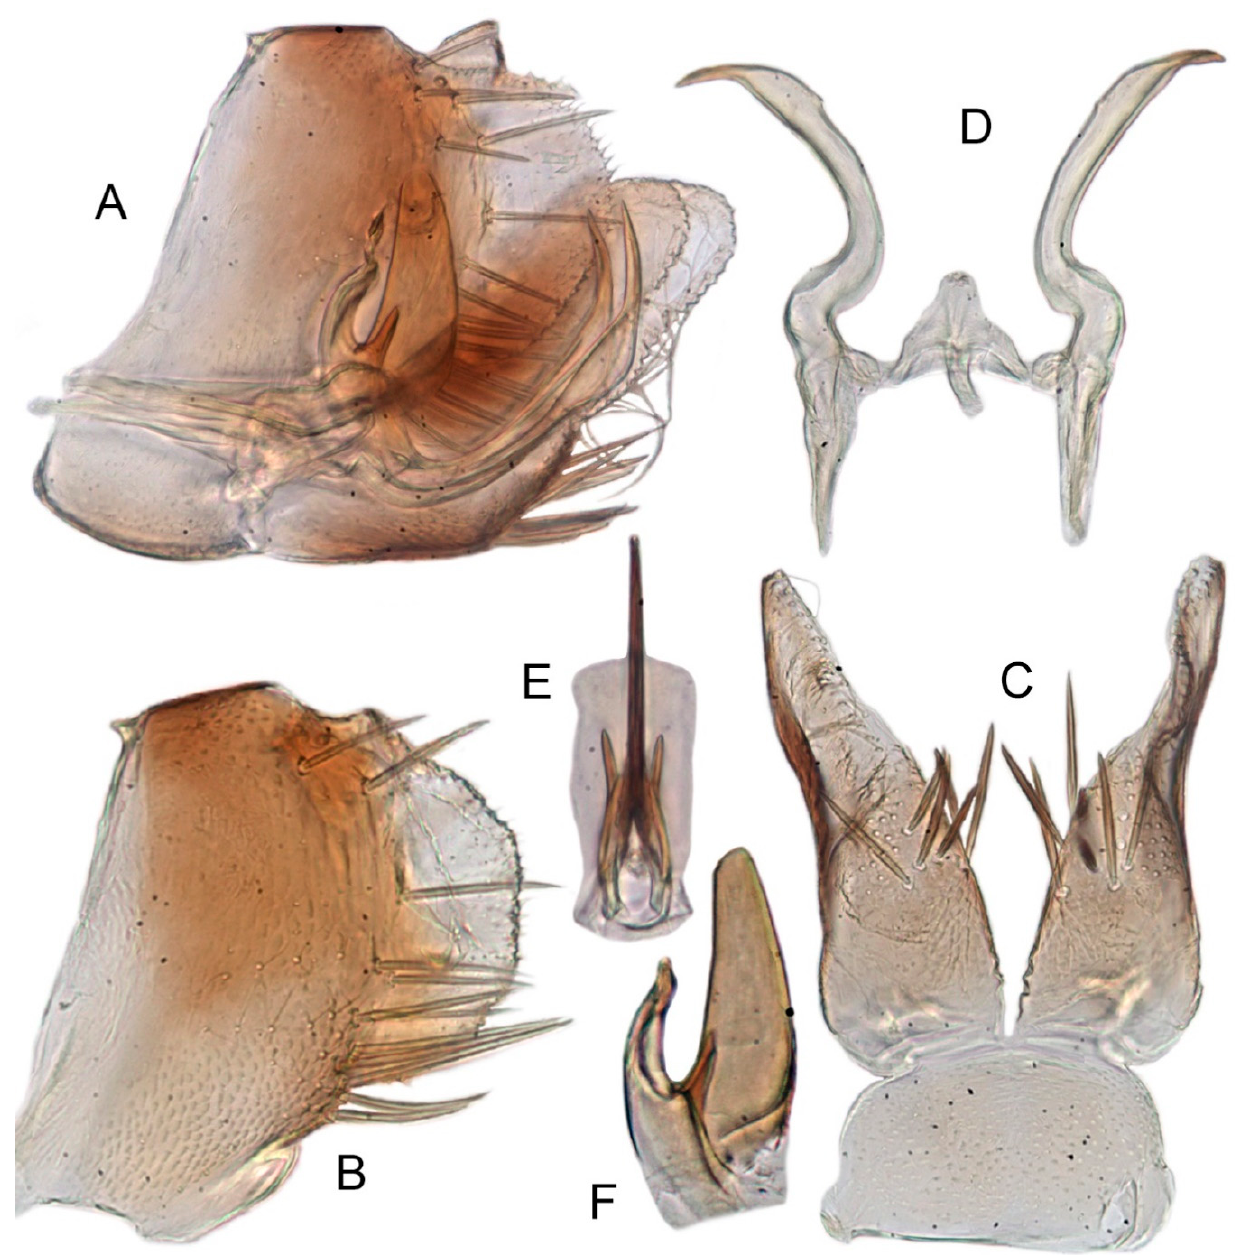
Figure 17. Xestocephalus abyssinicus Heller and Linnavuori, 1968, n. rec. ( A ) Male genital capsule, lateral view; ( B ) pygofer lobe, lateral view; ( C ) subgenital plates and valve, ventral view; ( D ) style and connective, ventral view; ( E ) aedeagus, posterior view; ( F ) aedeagus, lateral view.